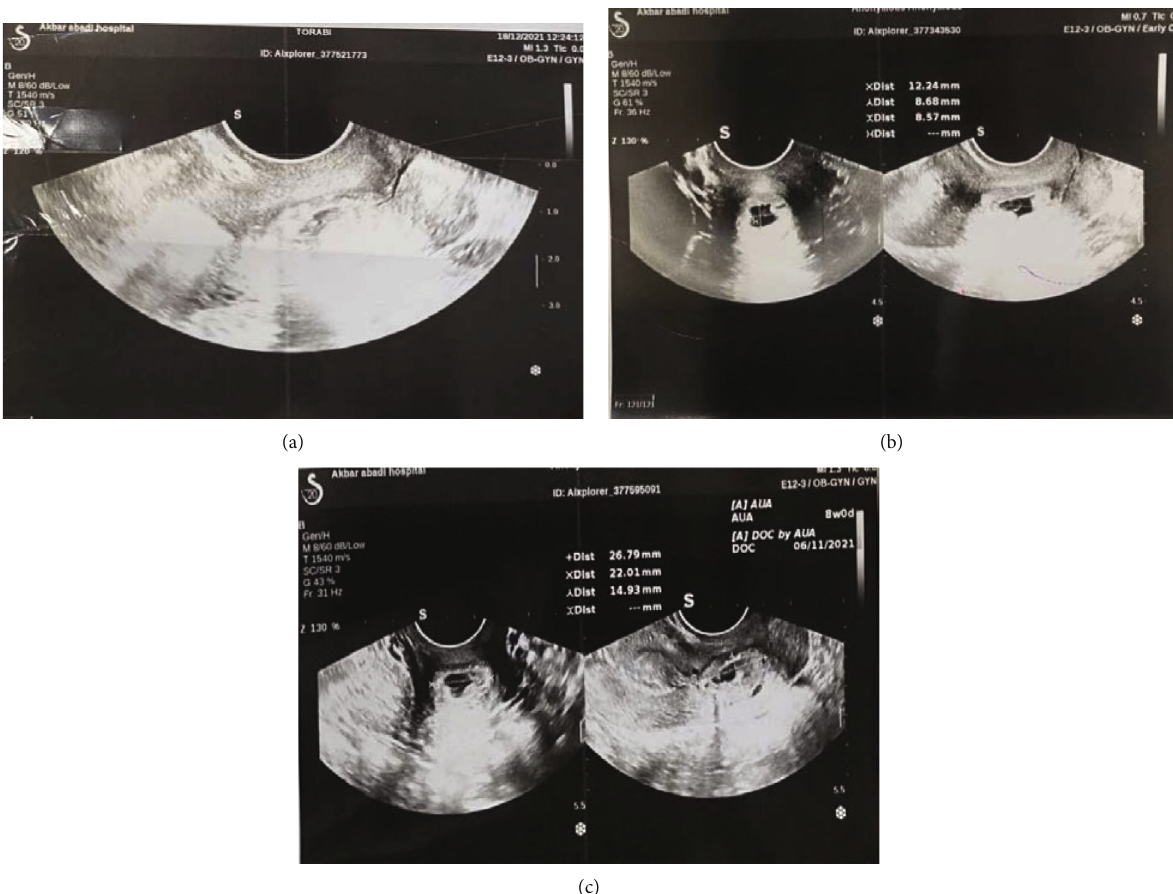
Figure 3: The 3 rd ultrasonography, a fetal echo (with FHR +) in the pregnancy bag.